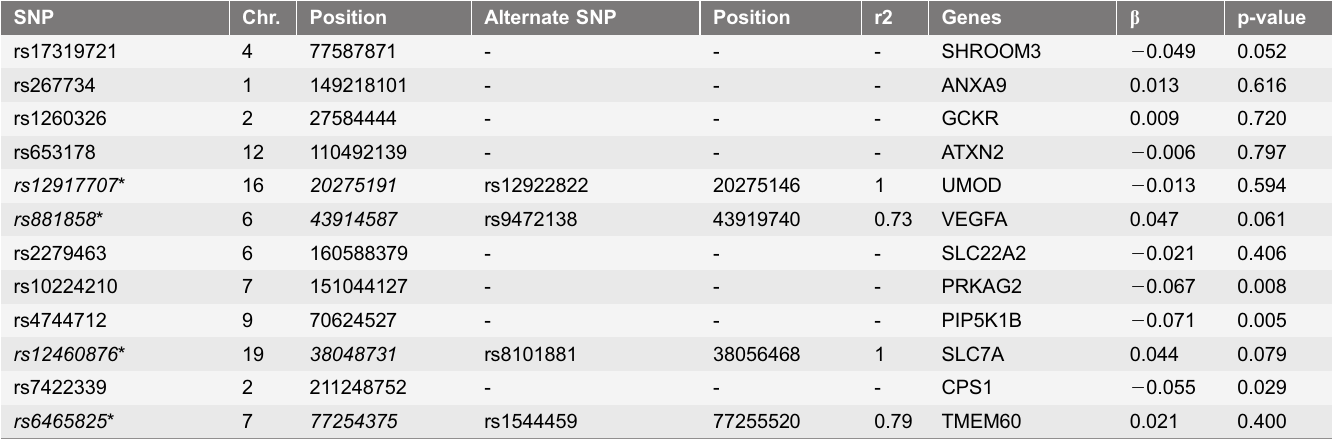
Table 2. Interrogation of known loci for association with eGFR.